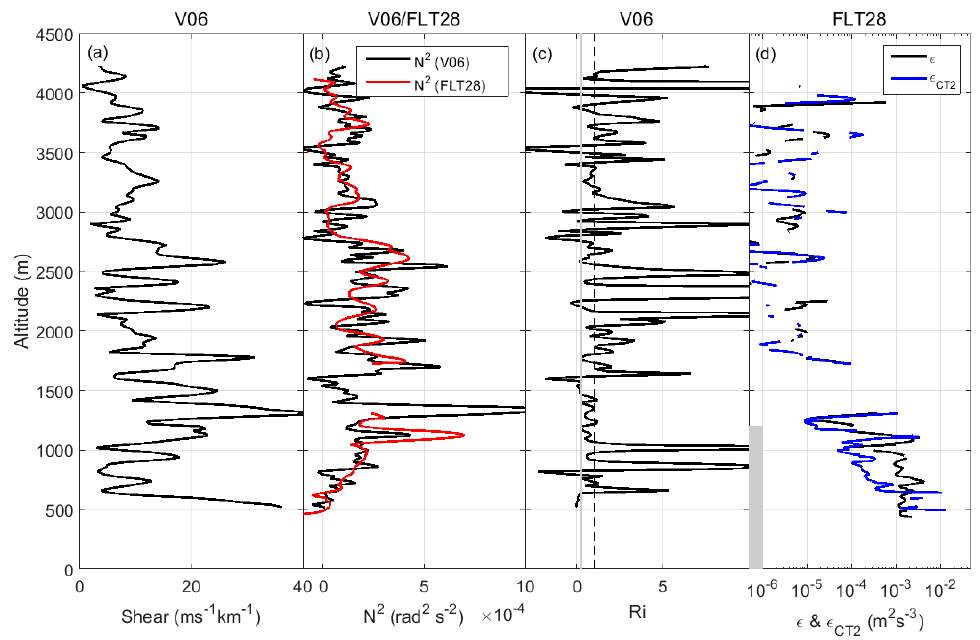
1/2 1/2 where u and v where u and v